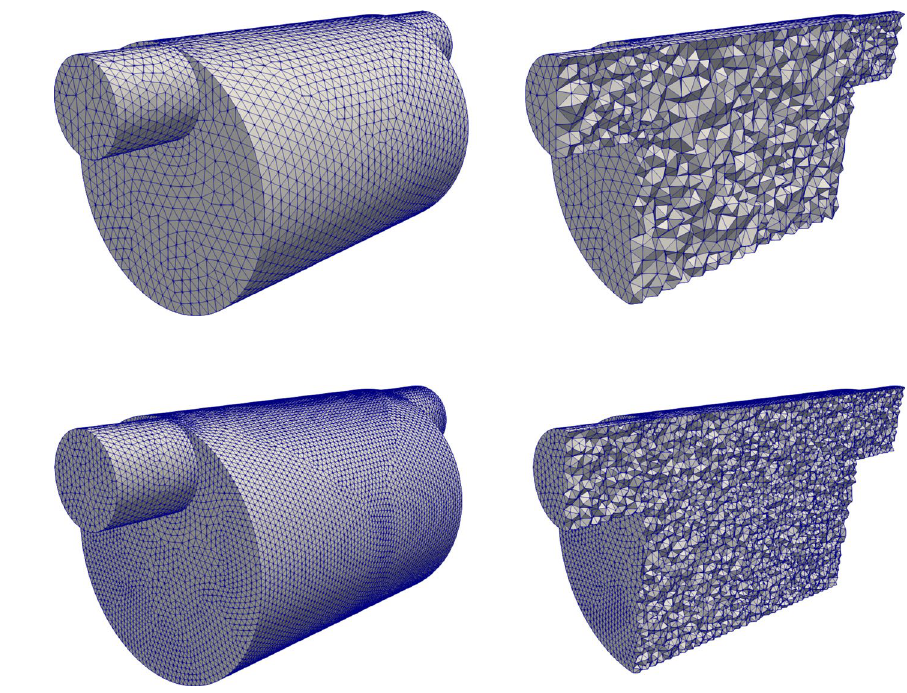
Fig. 4 Coarse mesh, left: the outer surface, right: cut in the middle along the elements for the sake of visualization